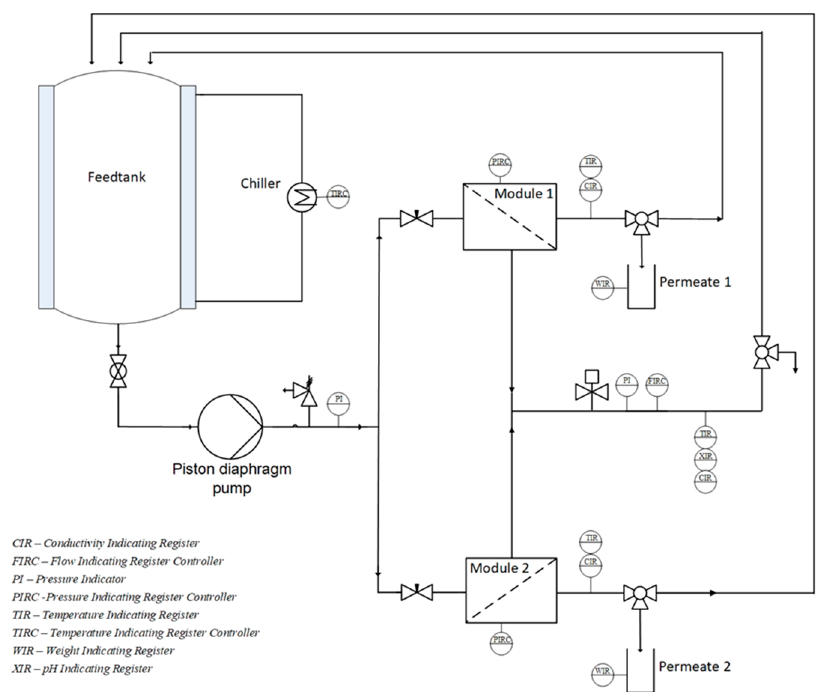
Figure 2. Flowchart of the laboratory crossflow membrane system.